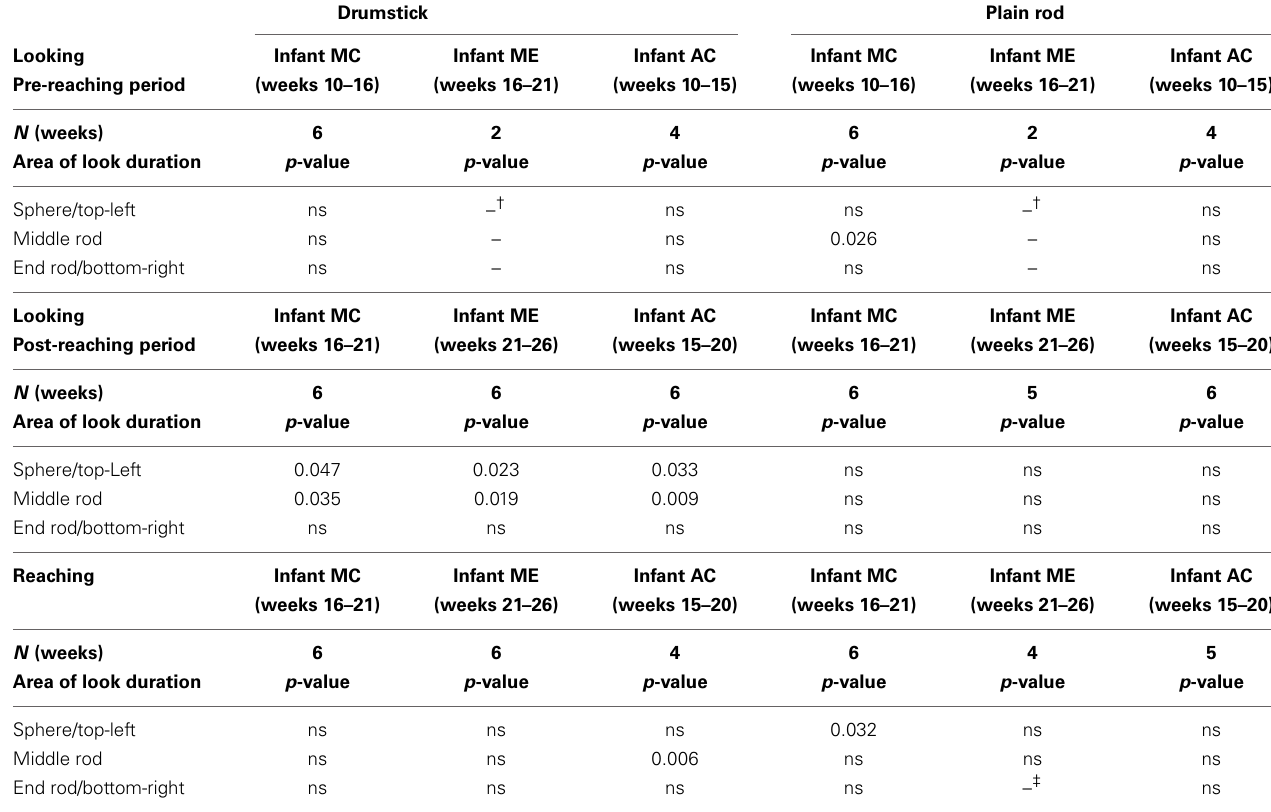
Table 4 | Developmental trends in looking distribution and first hand/object contact over the 6 weeks up to reach onset and 6 weeks from reach